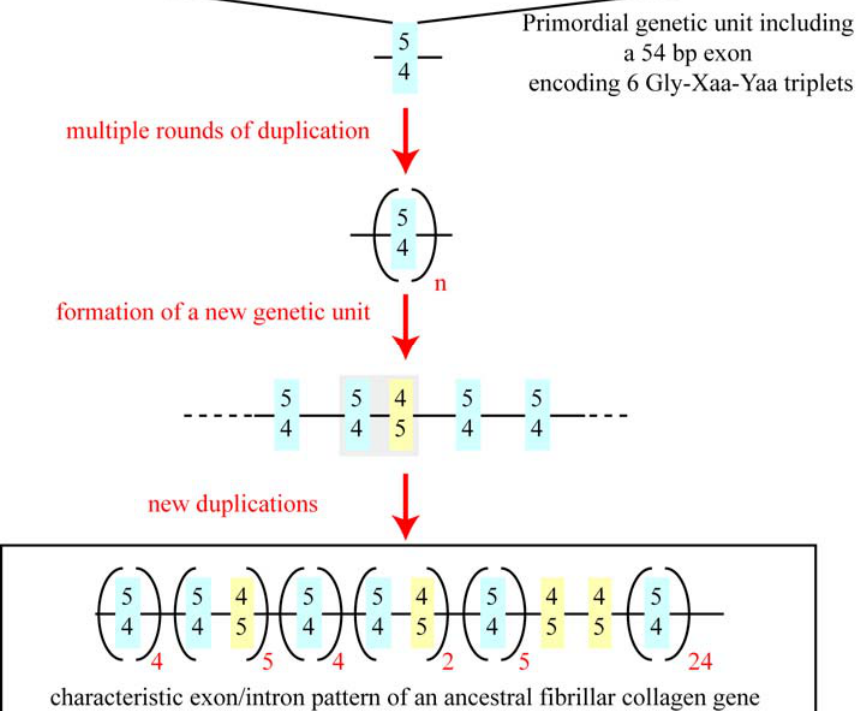
Figure 4. Hypothetical steps leading to the formation of an ancestral fibrillar collagen